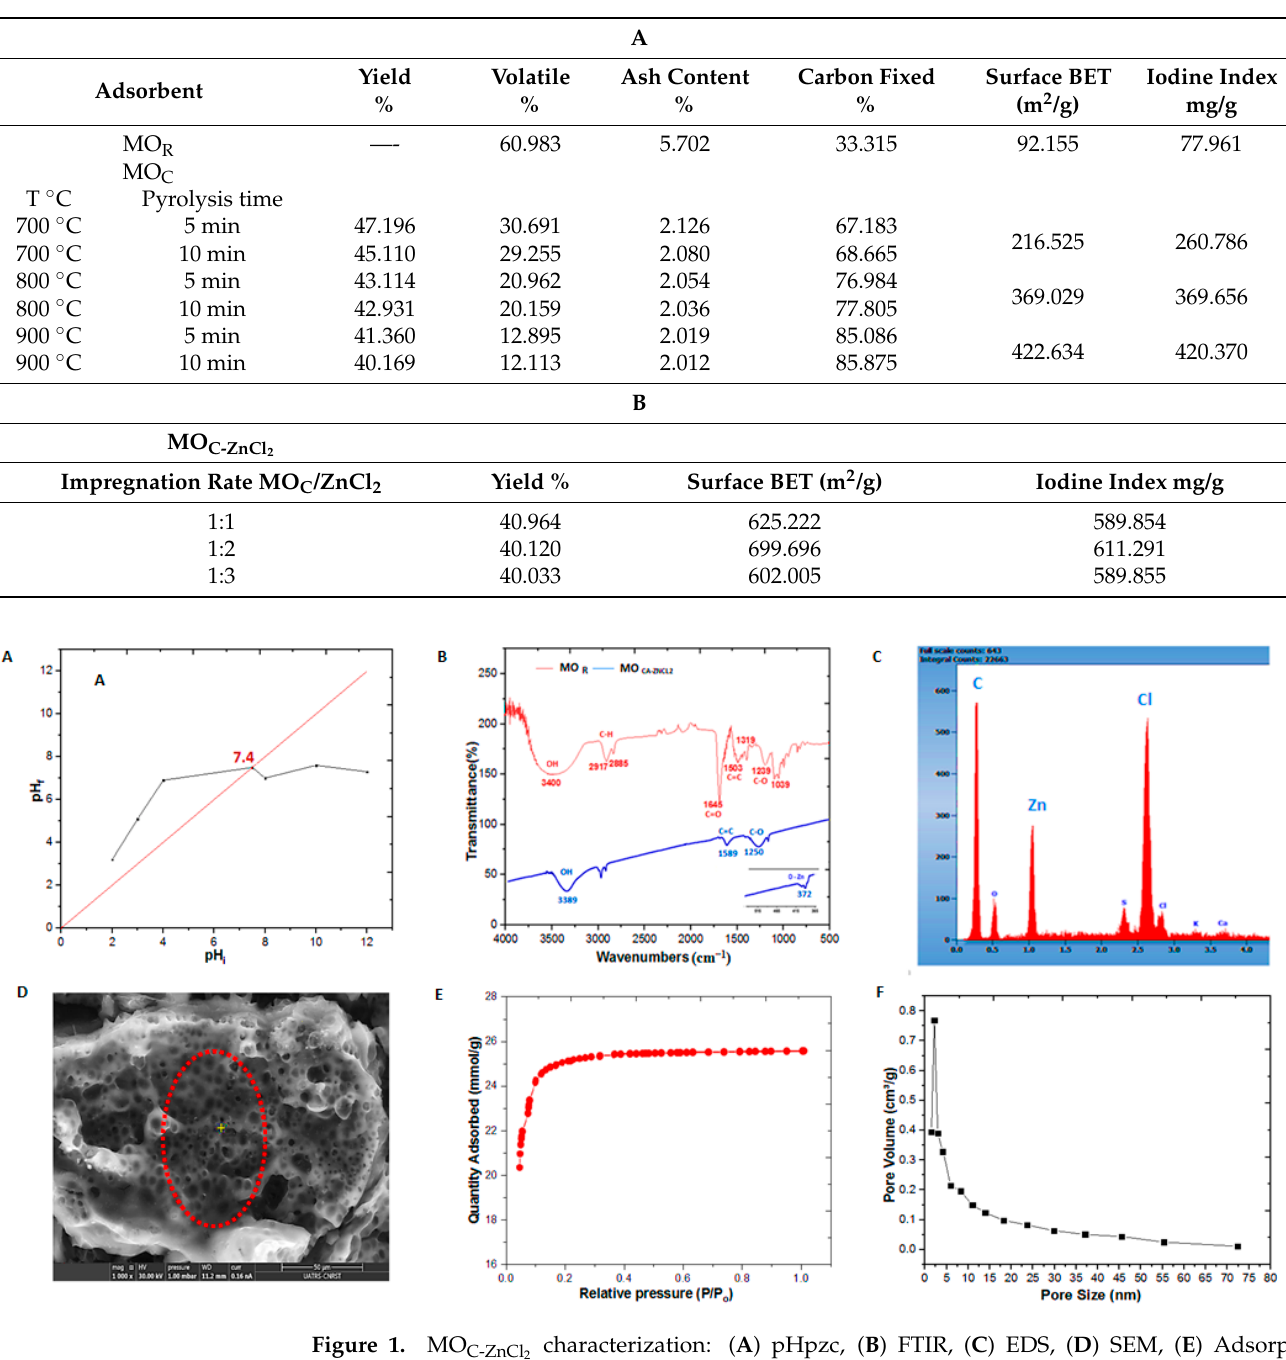
Table 1. A : Proximate analysis, Surface BET and Iodine Index of MOR and MOC at different temperatures and pyrolysis times; B : Yield, Surface BET and Iodine Index of MOC-ZnCl 2 at different impregnation rates MOC/ZnCl 2 .